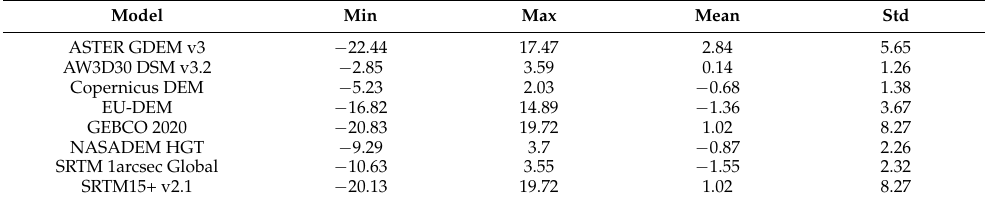
Table 4. Statistics of height differences between models and leveling at Northern traverse